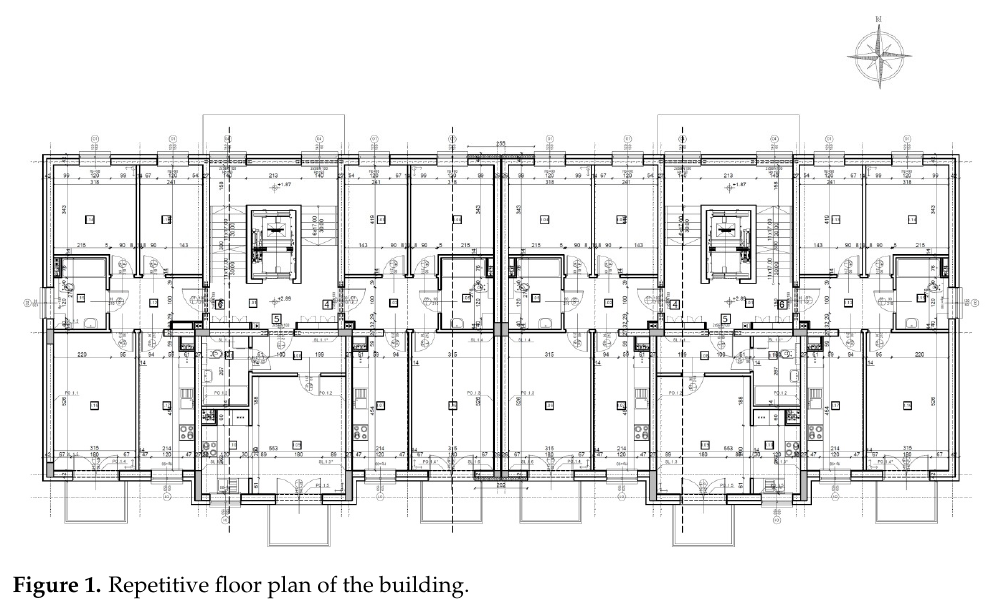
Figure 1. Repetitive floor plan of the building.